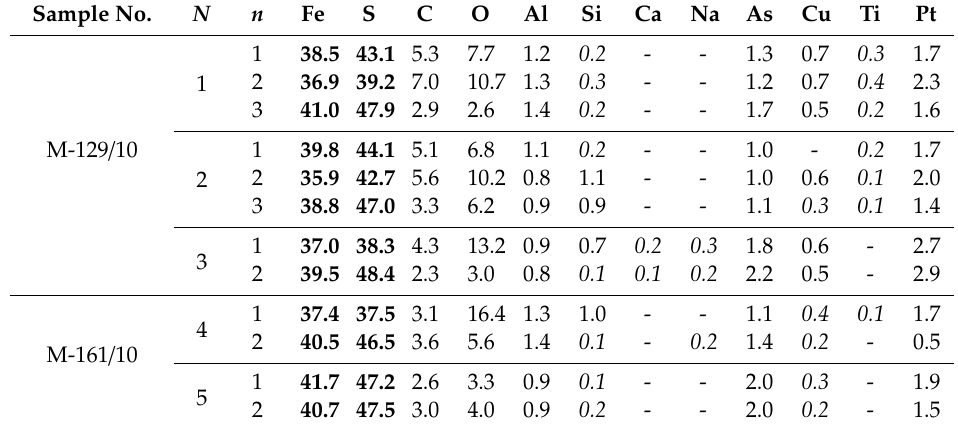
Table 9. Chemical composition (in wt%) of pyrite crystal surfaces with micron-size rare inclusions of non-metallic minerals. Samples from vein ores of the Natalkinskoe deposit. Sample No. N n